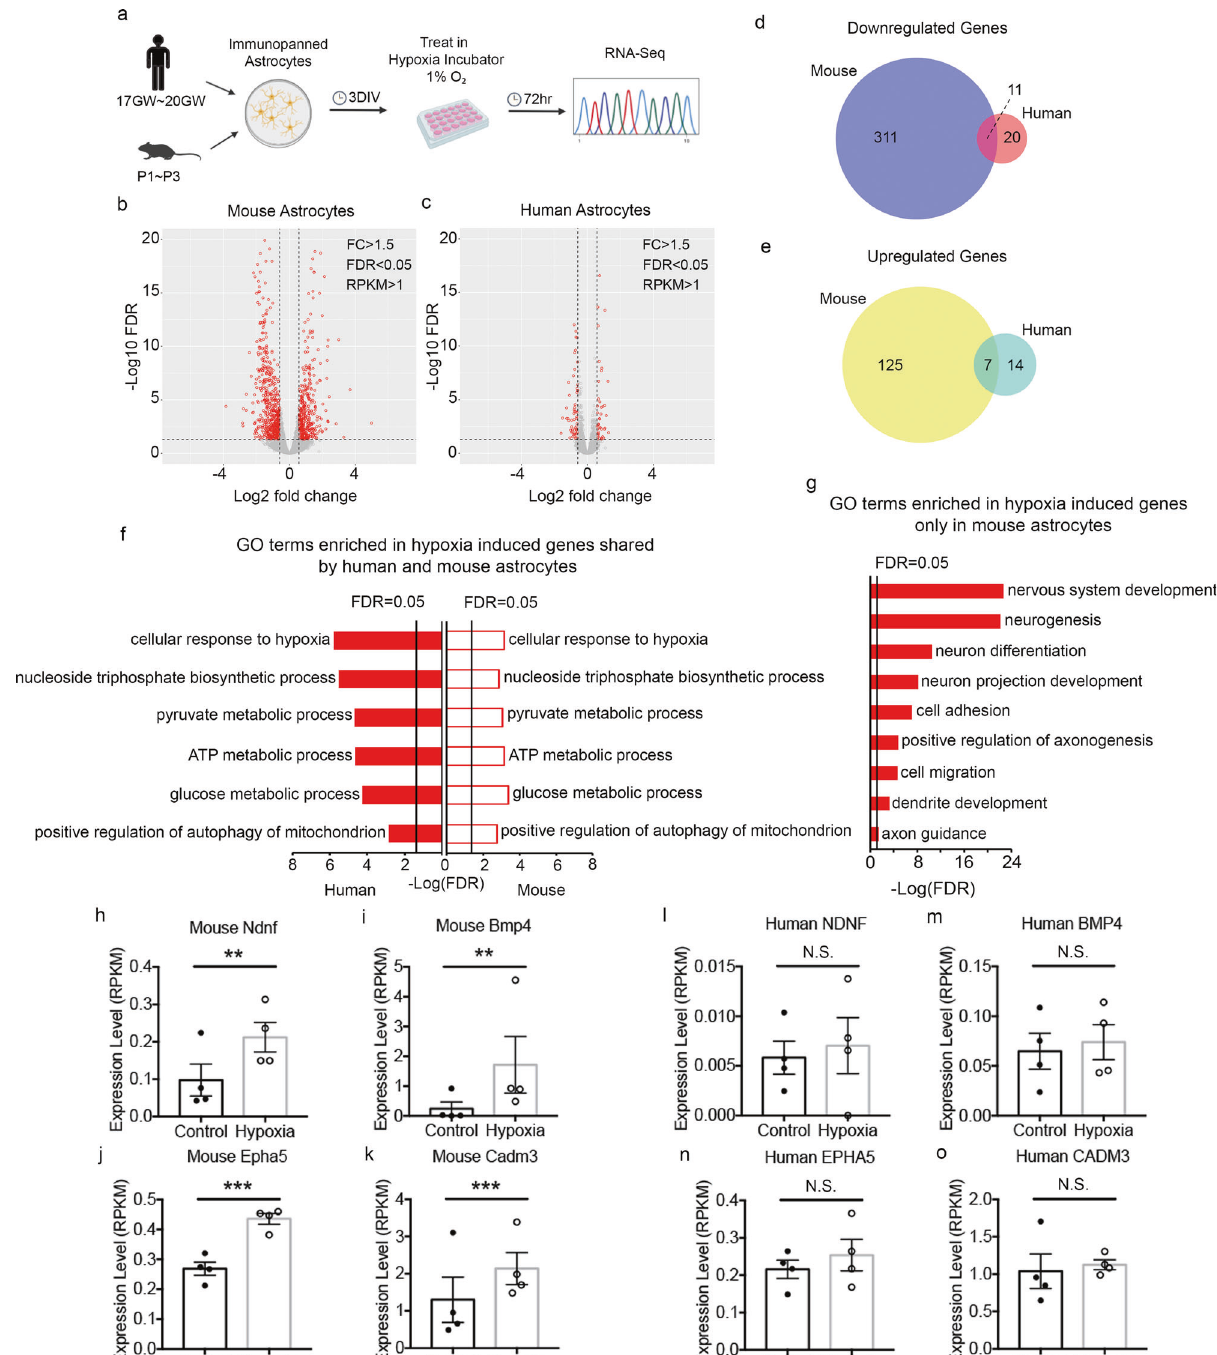
Fig. 6 Molecular responses of human and mouse astrocytes to hypoxia. a Experimental design. b , c Volcano plots of genes that signi fi cantly differ between hypoxia and control conditions. Each red dot represents a signi fi cantly different gene. FDR, false discovery rate. FC, fold change. RPKM, Reads Per Kilobase of transcript, per Million mapped reads. d , e The number of signi fi cantly up or downregulated genes in hypoxia-treated human and mouse astrocytes. Genes with FDR < 0.05, fold change > 1.5, and average RPKM of control or treated groups > 1 are shown. Genes in the overlapping regions are those meeting all three criteria in both species. f Top shared gene ontology (GO) terms enriched in hypoxia-induced genes in human and mouse astrocytes ranked by FDR. g Development-associated GO terms enriched only in hypoxia-induced genes in mouse but not human astrocytes. h – o Expression of genes associated with the GO term nervous system development in control and hypoxia-treated human and mouse astrocytes. N = 4 litters of mice and 4 human patients. Mouse: Ndnf, p = 0.002; Bmp4, p = 0.0015; Epha5, p = 0.0003; Cadm3, p = 0.0001. Multiple comparison-adjusted p values were calculated by the DESeq2 package. N.S., not signi fi